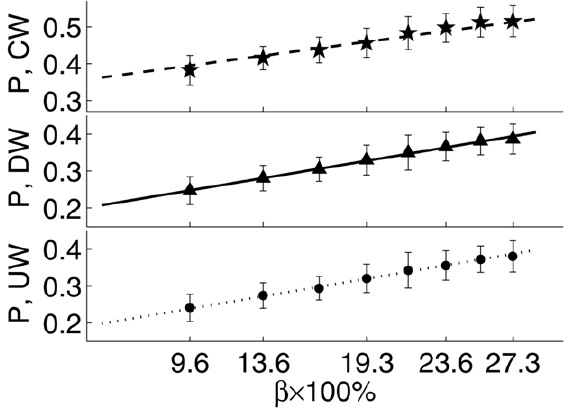
Figure 7. The proportion of mosquitoes finding a host as a function of host density. The simulation results are given by the solid markers with + one standard deviation (UW = upwind, DW=downwind, CW=crosswind). The lines are linear fits to the data using the formula P ~ P 0 z b (1 { P 0 ) , where P 0 is a free parameter and b is the length of a side of the square host patch divided by the length of a side of the simulation region. As b increases, the hosts spread out (i.e., decrease in density) and the number of mosquitoes locating a host increases. The x { axis is b labeled as a percentage.